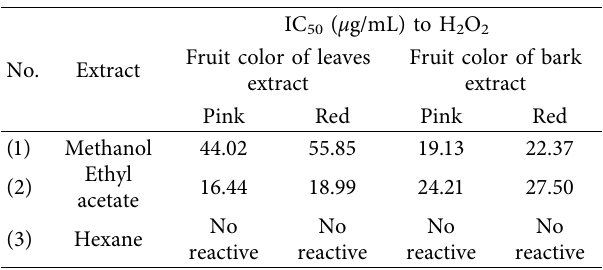
50 ) of S. aqueum leaves and